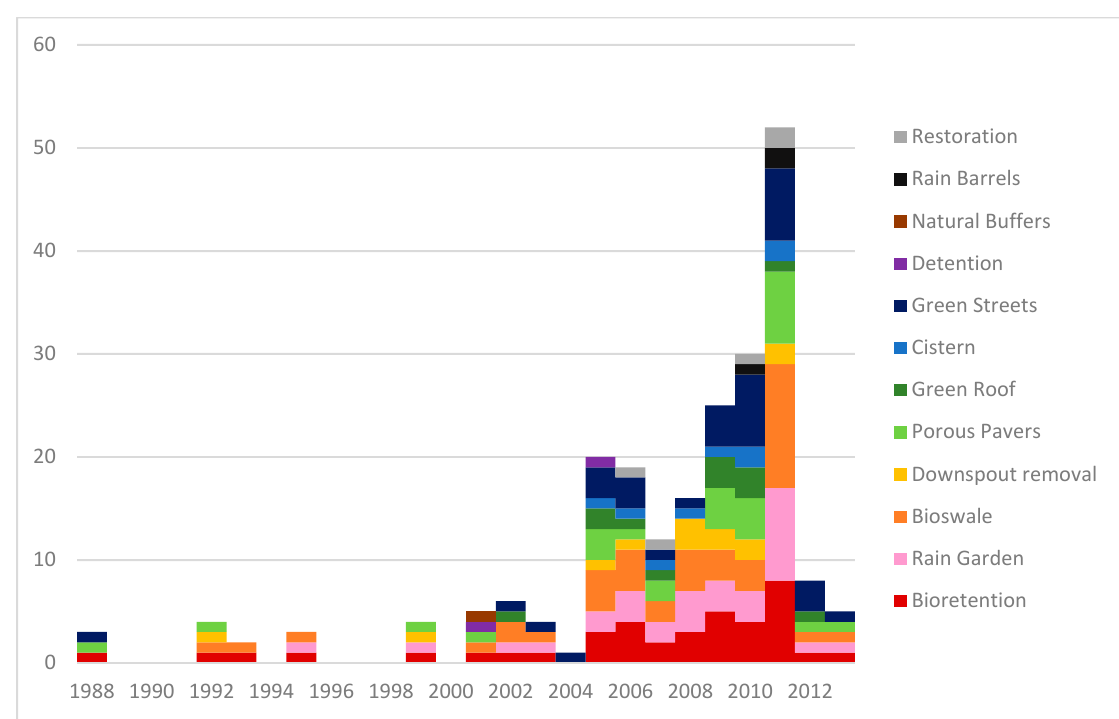
Figure 5. GI technology use by year (1988–2013).